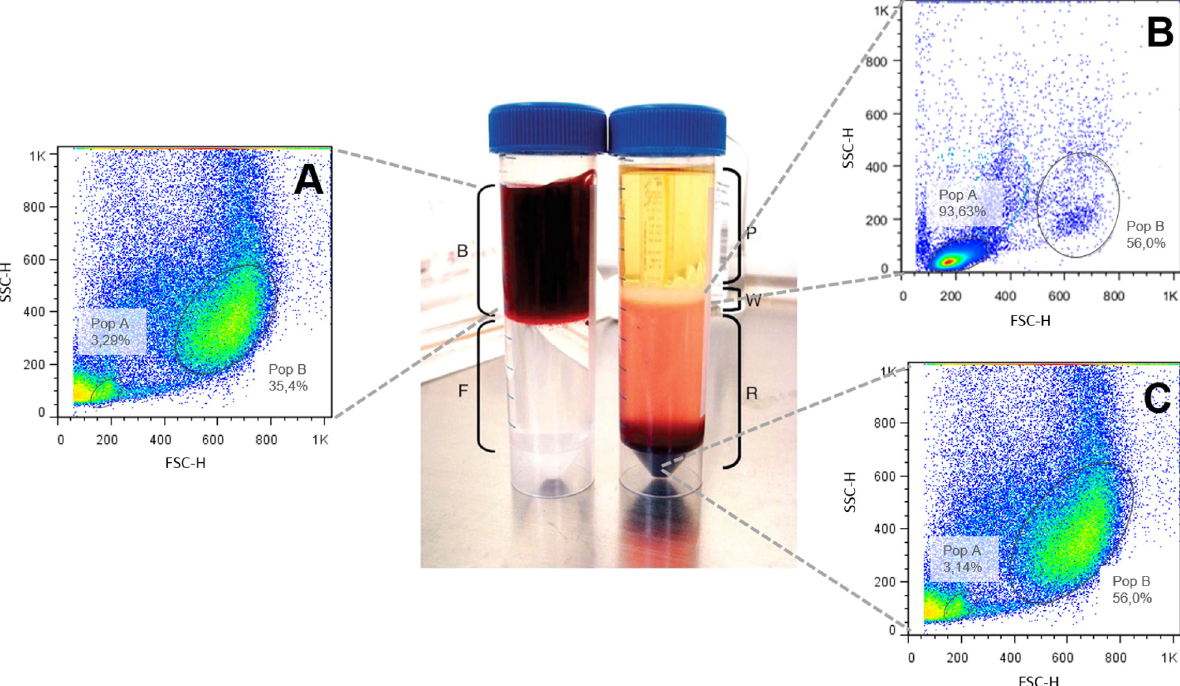
Fig 1. Blood cells populations of O . niloticus after separation by Ficoll gradient. (A) Whole blood, (B) ring of lymphocytes/thrombocytes — Pop. A and (C) erythrocytes rich population – Pop. B using SSC (side scatter) X FSC (forward scatter) parameters.